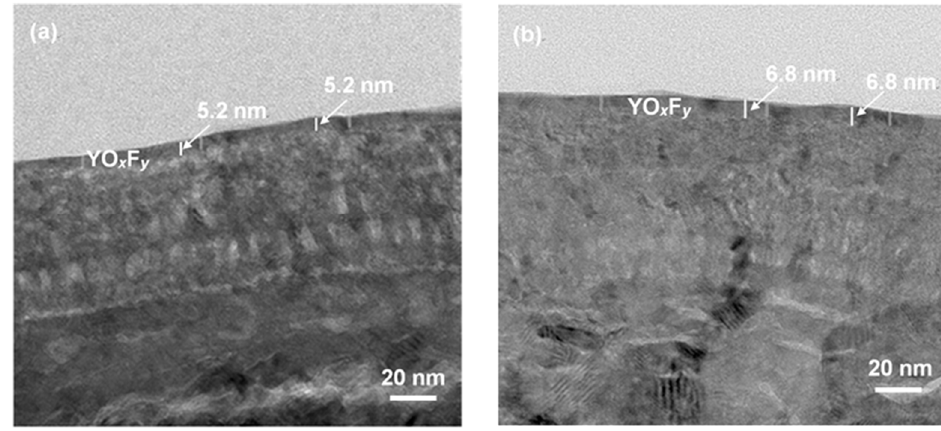
Figure 6. TEM microstructures of ( a ) Y 2 O 3 and ( b ) YF 3 coatings after exposure to the fluorocarbon plasma.